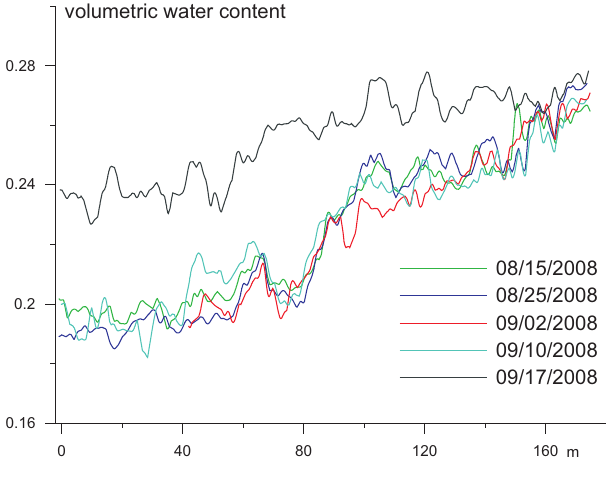
Fig. 8. Transect T2: average volumetric soil water content of the active layer. The radargram obtained on 2 September can not be evaluated between 0 and 40m ( refer to Fig. 5).